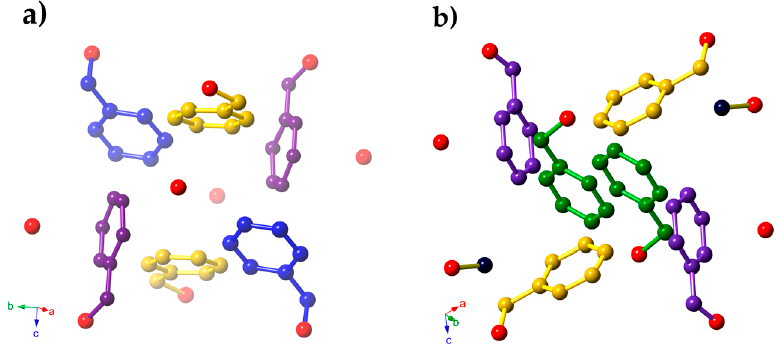
Figure 4. Views of the interactions between benzyl groups that occur in the disordered hexaphenyl aggregates in ( a ) Co 2 (BzOip) 2 (H 2 O) · 0.19H 2 O prepared in aqueous ethanol; and ( b ) Co 2 (BzOip) 2 (H 2 O) · 0.29H 2 O 0.29MeOH prepared in aqueous methanol. Benzyl groups depicted using the same colours are related by symmetry. Hydrogen atoms have been omitted for clarity.